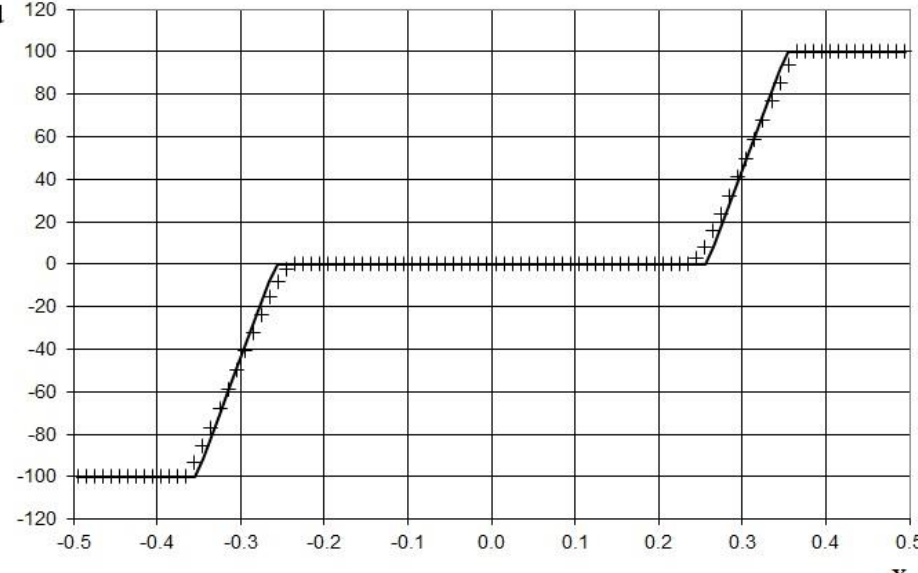
Figure 18. Velocity plot for the double expansion wave problem (47) for the one-dimensional scalar hyperbolic conservation law, using the coarse grid (100 grid points): the exact solution (line), and the present method (cross).